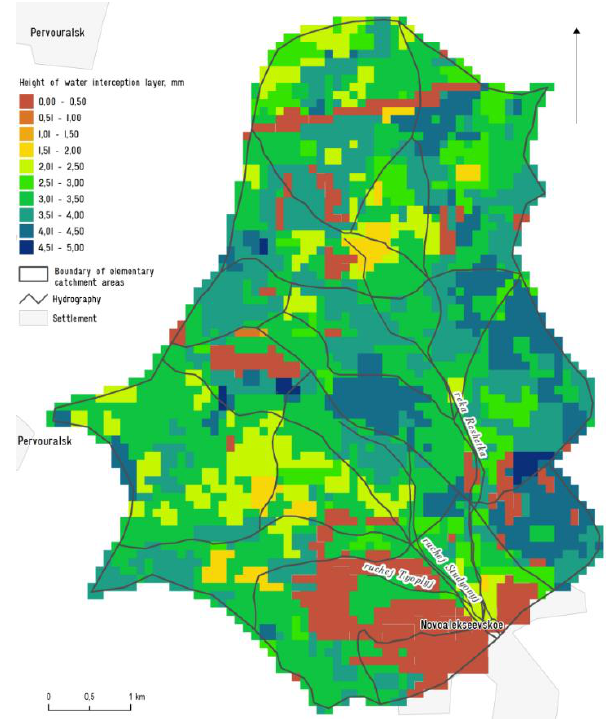
Figure 8. Map of canopy precipitation interception.